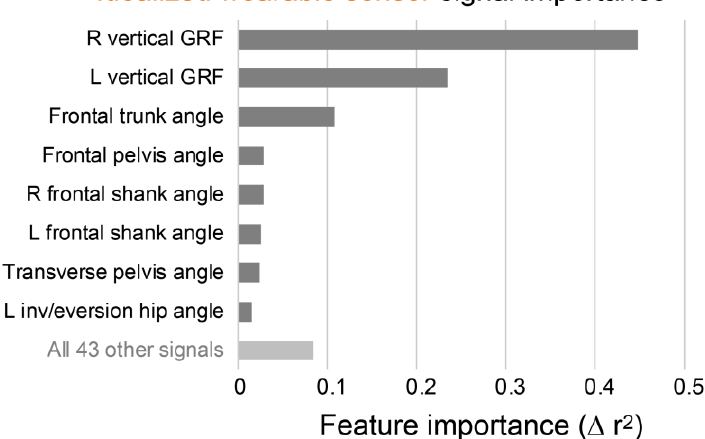
Figure A4. Vertical GRFs and frontal trunk angle are the most important signals for estimating lumbar lateral bending moments. Signal importances are from the idealized wearable sensor algorithm for estimating the lumbar lateral bending moment. Note that these signals can be obtained from the same two sensors (trunk IMU and pressure insoles) that we identified as being the most important for estimating the lumbar extension moment. R = right; L = left.